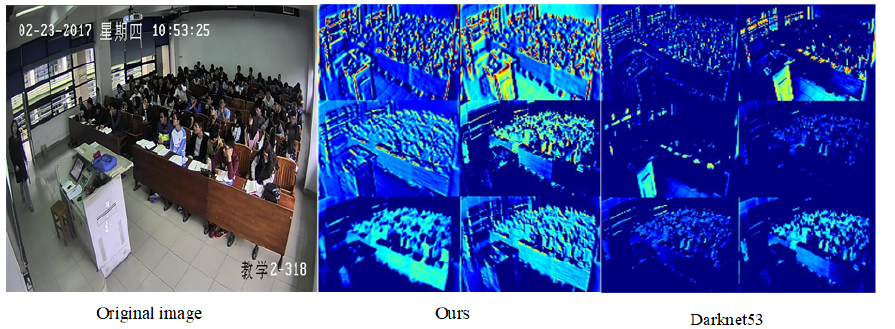
Figure 4. Comparison of DR-Net and Darknet-53 partial shallow feature map